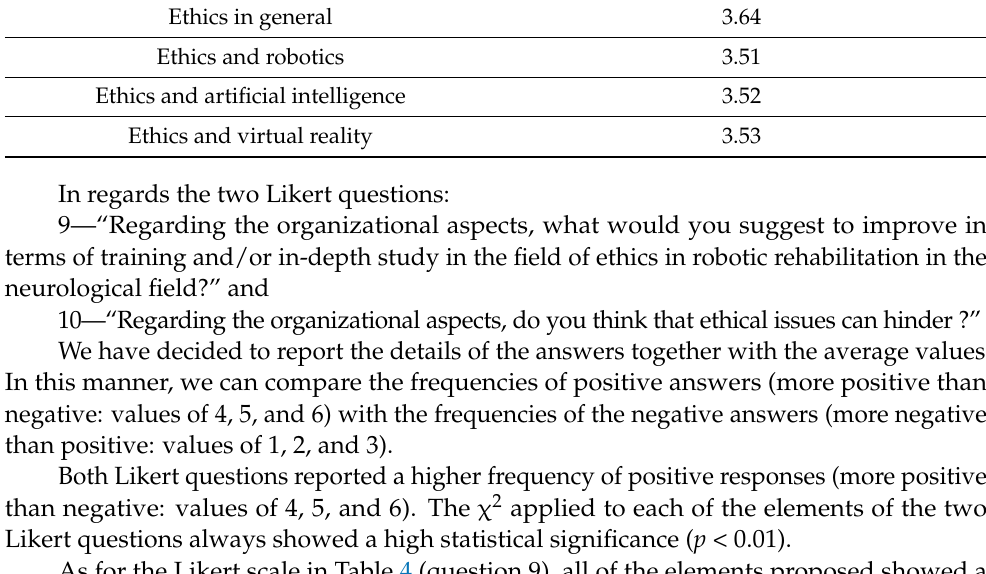
Table 3. Output from the Likert scale “Evaluate your current knowledge in ethics in relation to the following aspects”. Question Score Ethics in general